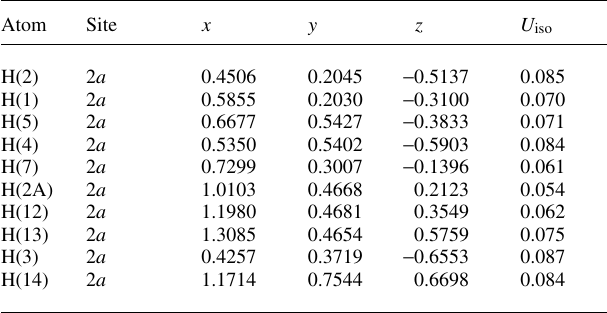
Table 2. Atomic coordinates and displacement parameters (in Å 2 )